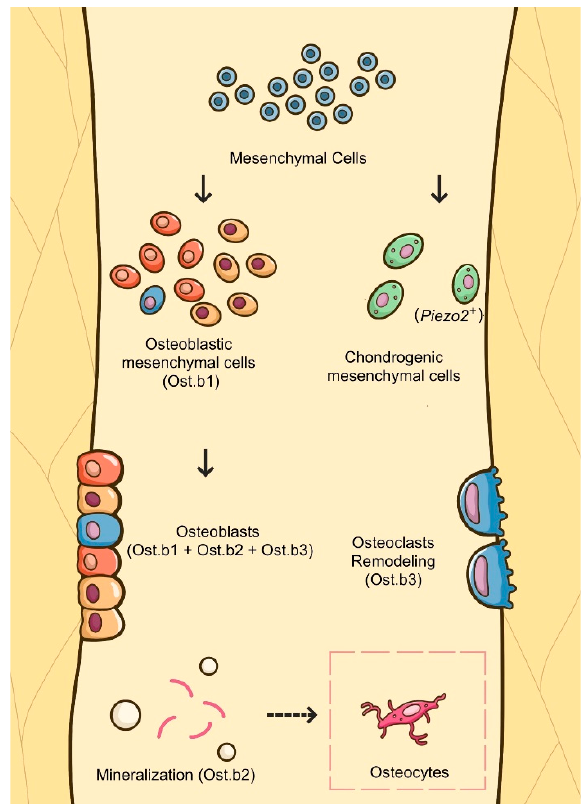
Figure 6. A schematic diagram recapitulating the mechanism in the maturation and ossification processes of the midpalatal suture. Mesenchymal cells are selected for their potential involvement in the maturation and ossification process of the midpalatal suture. Osteoblastic mesenchymal cells are divided into three clusters (Ost.b1, Ost.b2, and Ost.b3) and play various roles in intramembrane osteogenesis processes. Mesenchymal cells proliferate, condense (Ost.b1), and differentiate into osteoblasts (Ost.b1, Ost.b2, and Ost.b3). Osteoblasts shape an ossification center, secrete osteoid, induce mineralization (Ost.b2), and transform into osteocytes. Bone remodeling emerges throughout the whole procedure (Ost.b3). Additionally, Piezo2 + chondrogenic mesenchymal cells might be linked to mechanical stimulus detection and may play a key role in the osteogenic processes of the midpalatal